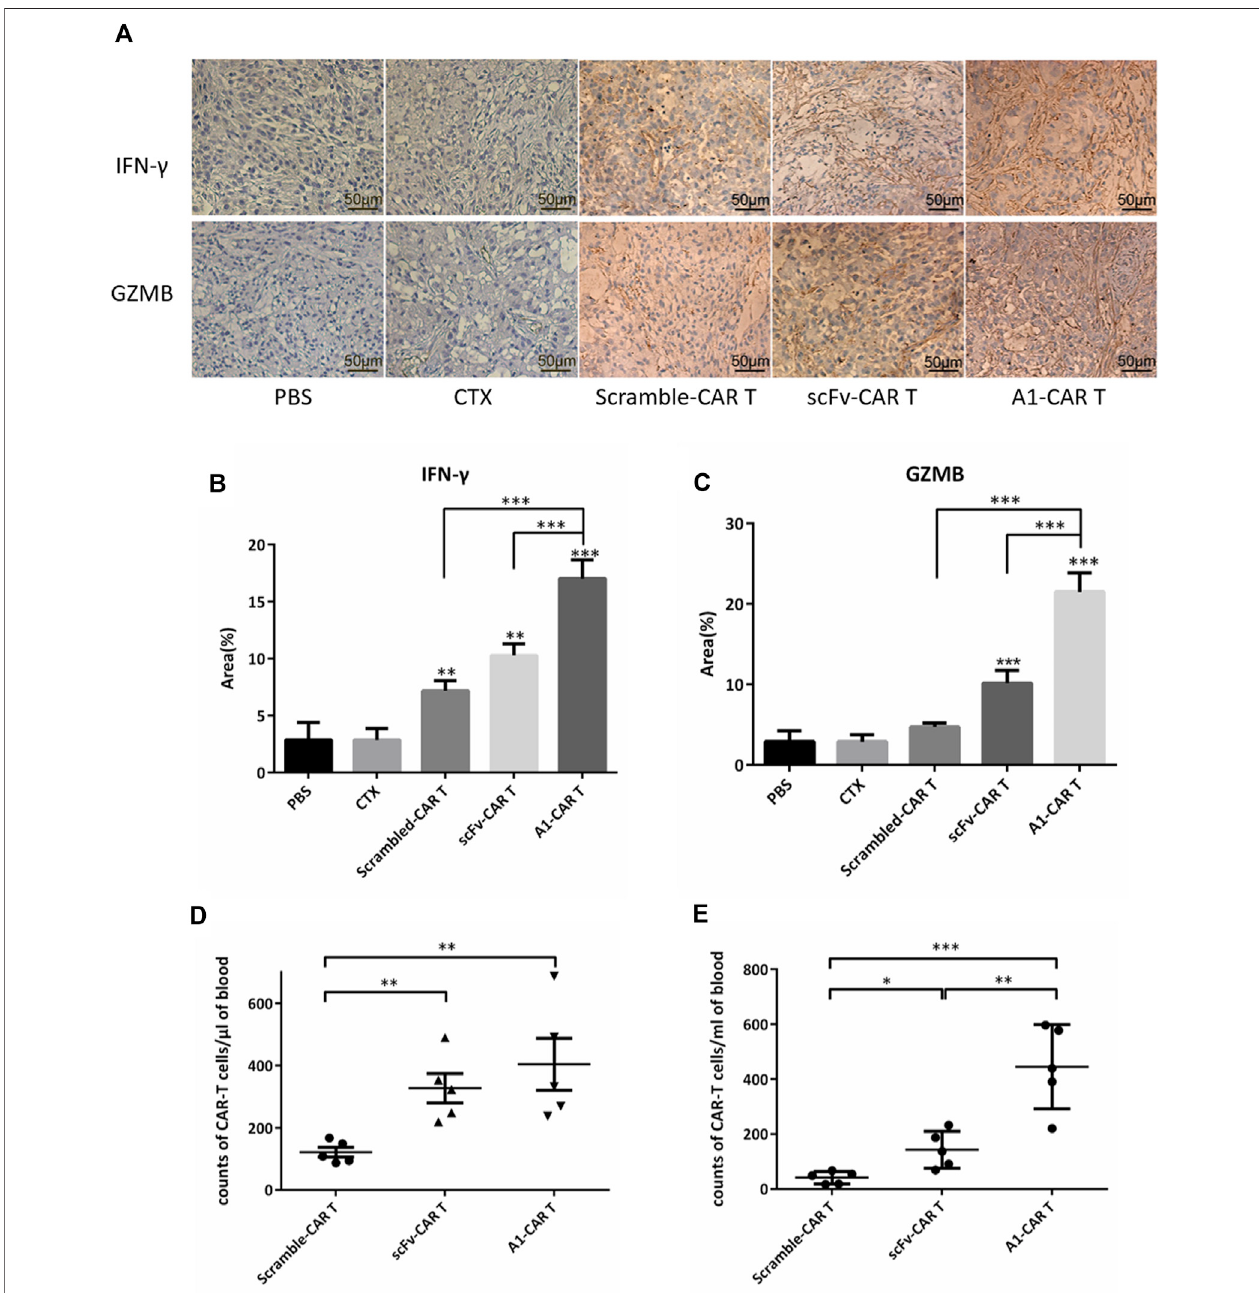
FIGURE4 | Peptide-based CARs had robust expansion abilityand long-term functionalpersistence invivo . (A) IFN- γ and GZMB immune staining images of tumor tissues from various groups. (B,C) Immunohistochemical quantitative analysis of IFN- γ and GZMB. Data were given as mean ± SD from fi ve independent experiments. *** p < 0.001. T tests were utilized to decide the p values. (D,E) After 1 day and 21 days following infusion of CARs, CARs in peripheral blood were quanti fi ed by fl ow cytometry. n = 5 mice. Data is shown with mean ± SD. * p < 0.05, ** p < 0.01, *** p < 0.001. T tests were utilized to decide the p values.